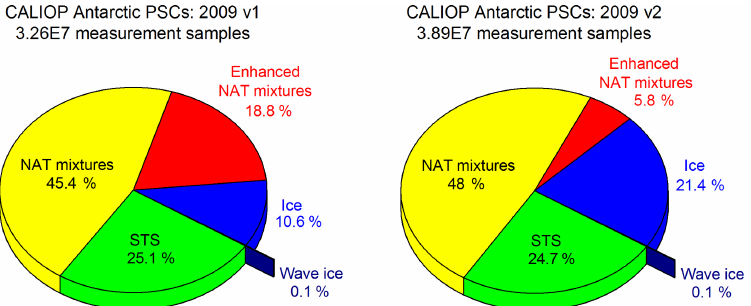
Figure 11. Comparison between v1 and v2 CALIOP PSC observations during the 2009 Antarctic winter and their breakdown by composition classification. Data are restricted to altitudes of 4km or higher above the tropopause to avoid distortion of statistics by ubiquitous underlying